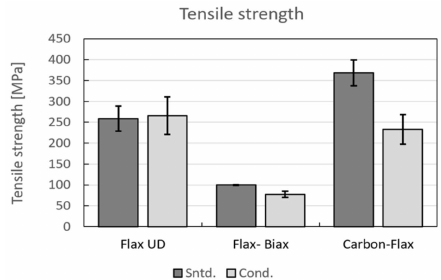
Figure 9. Tensile strengths of conditioned samples.